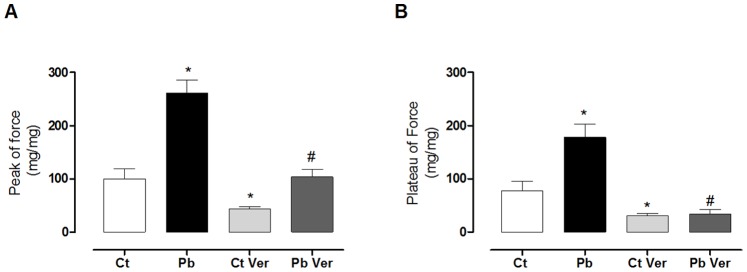
Peak and plateau of the isometric force in isolated left ventricular papillary after tetanic stimulation in the absence and presence of verapamil (Ver) of control (Ct), lead treated (Pb), control+verapamil (Ct Ver), lead treatred+verapamil (Pb Ver).Each column represents the means ± SEM. Number of animals = 6 for each group. *p<0.05, Pb vs. control, one-way ANOVA, followed by Tukey’s test.